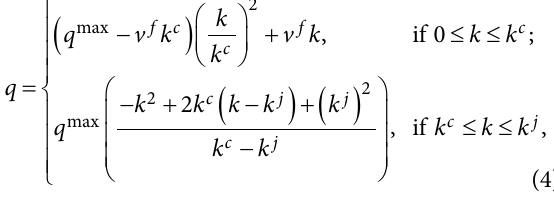
Fig. 2. A bottleneck